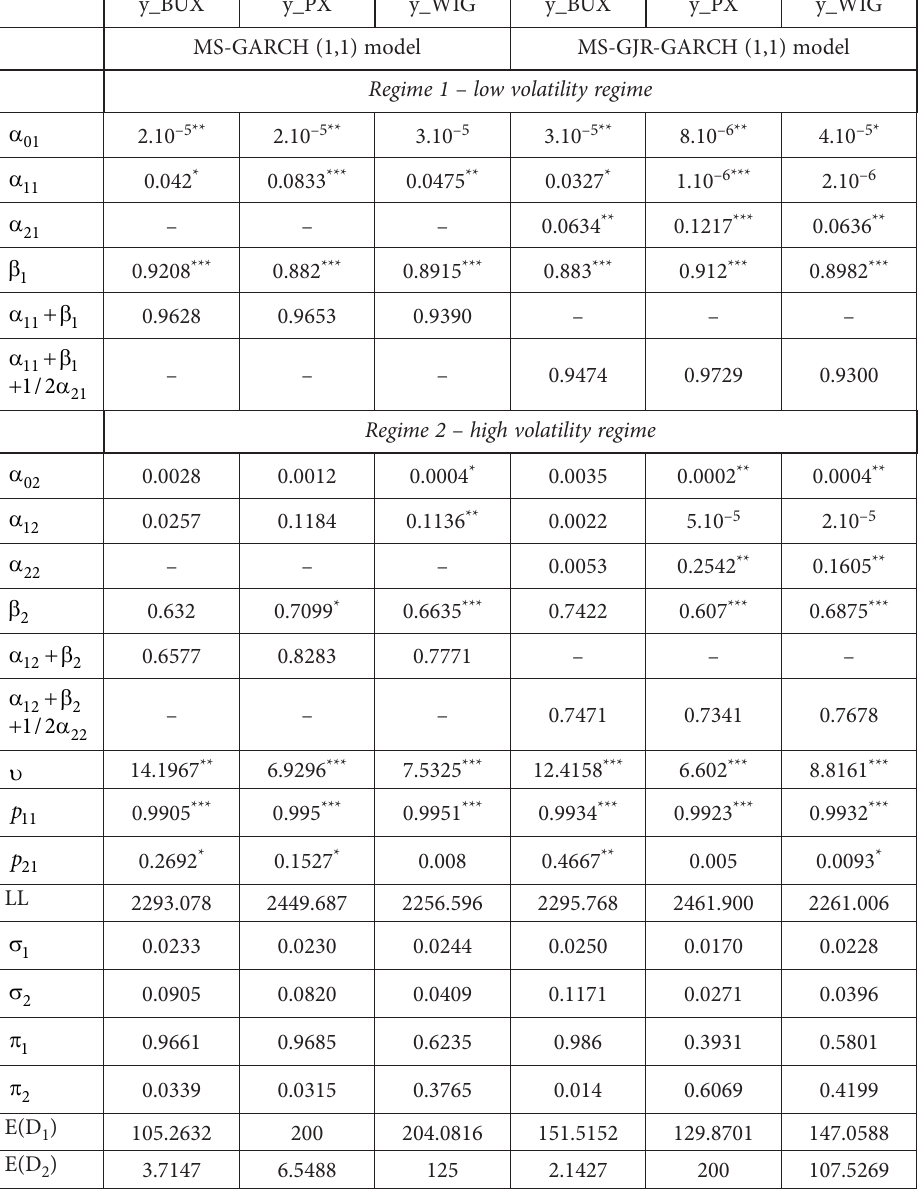
Table 4. Estimation results of MS-GARCH (1,1)/MS-GJR-GARCH (1,1) models with t -distribution, two regimes (source: own calculations in R, package